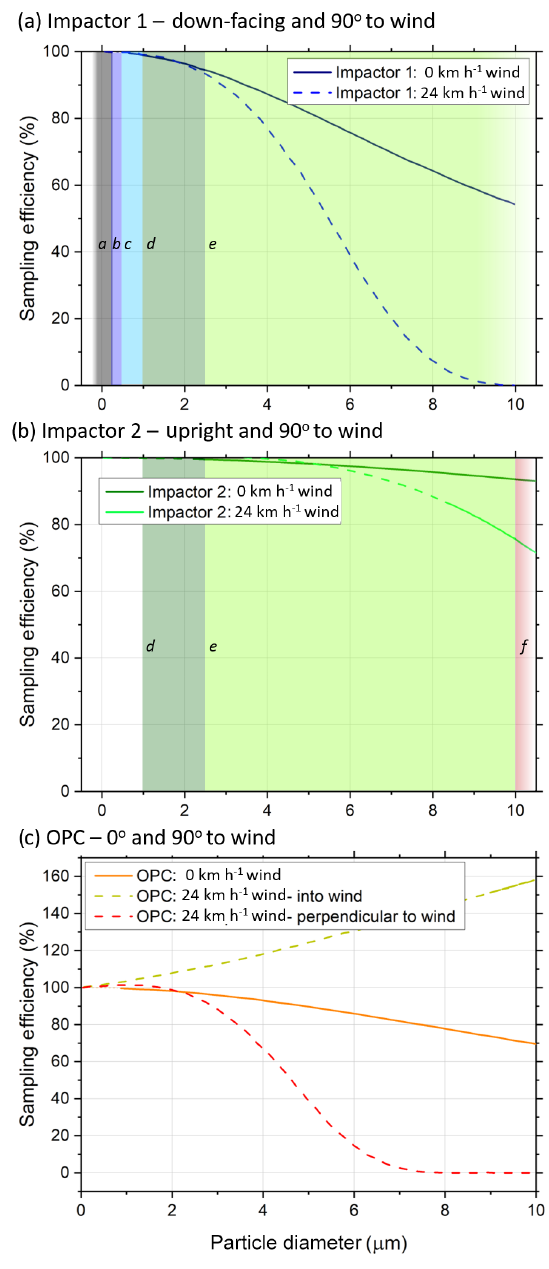
Figure 3. SHARK sampling efficiencies. (a) The sampling efficien- cies of Impactor 1, with and without wind, when sampling at 90 ◦ to the wind direction. (b) The sampling efficiencies of Impactor 2, with and without wind, when sampling at 90 ◦ to the wind direction. (c) The sampling efficiency of the OPC, with and without wind, when sampling at 0 and 90 ◦ to the wind direction (the OPC was deployed at 0 ◦ to the wind, based on this calculation). Solid lines denote model predictions within the validity range of the formulas, and dotted lines represent approximations (Von Der Weiden et al.,